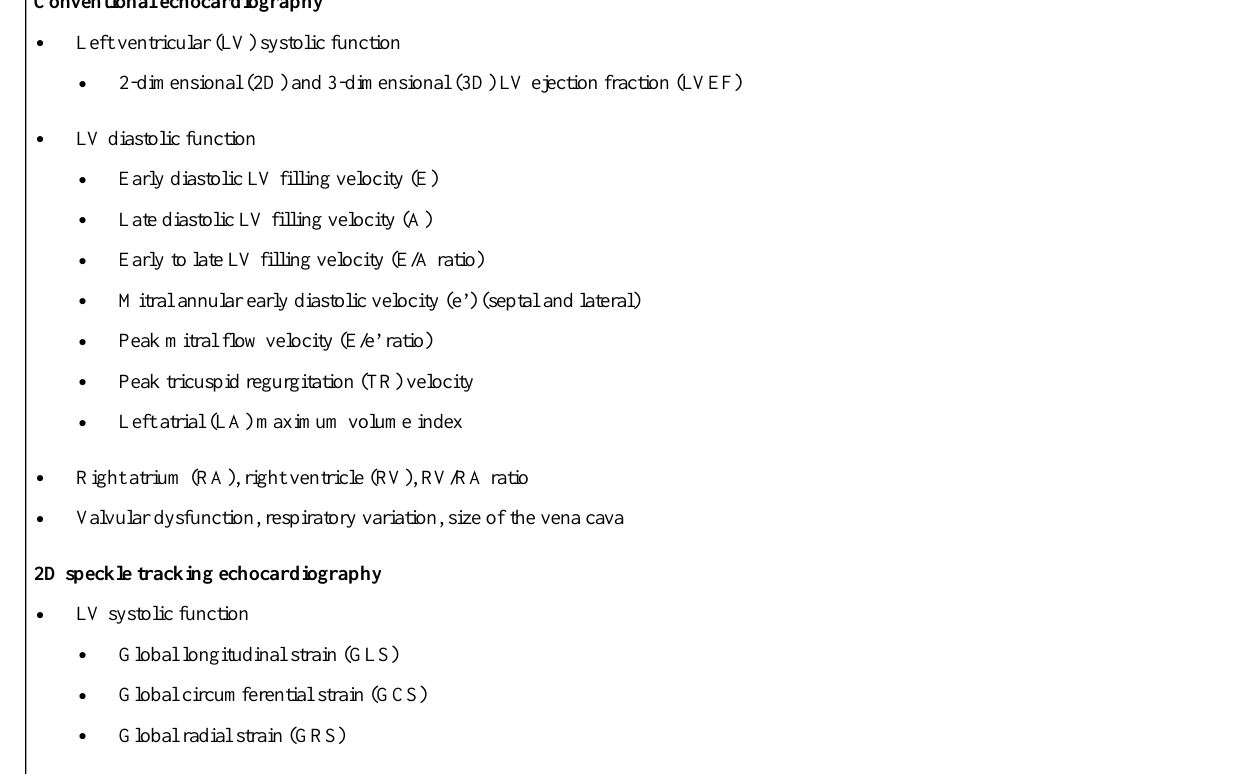
Textbox 1. Components of cardiac assessment collected for childhood cancer survivors. Conventional